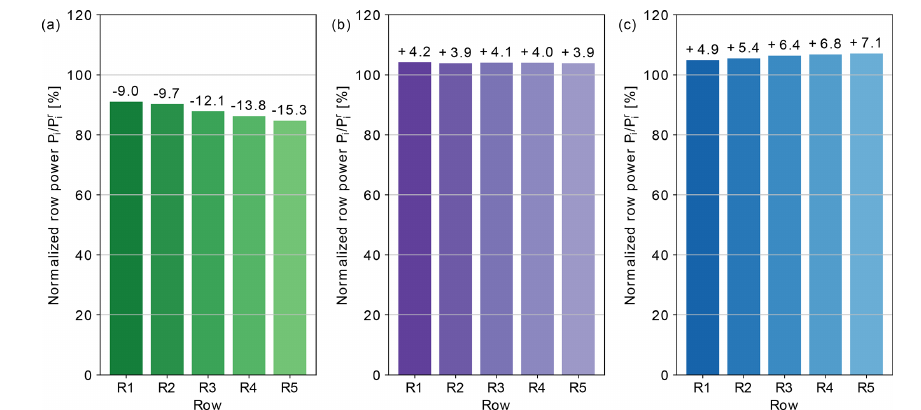
r i for the AWE parks